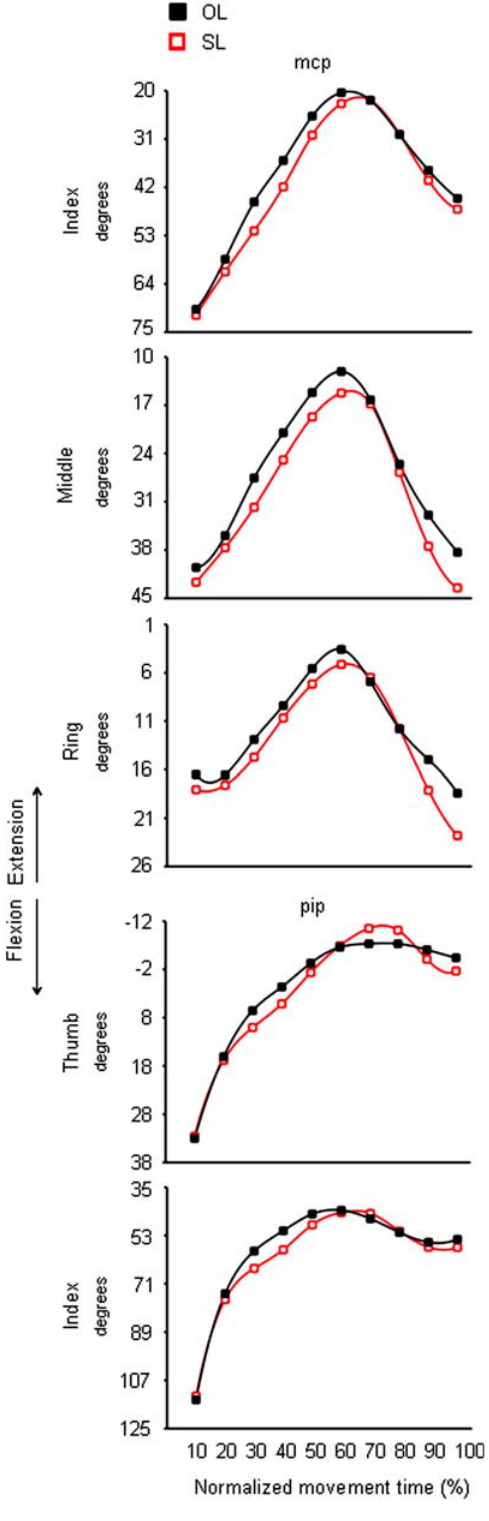
Figure 6. Time course of finger motion during reaching for the large target either in the absence or in the presence of an odour evoking a small object. Each trace denotes the average angular excursion of a representative subject (subject 15) for the mcp joint of index, middle and ring fingers (upper panels), and the pip joint of the thumb and index finger (lower panels) when performing the ‘OL’ (black squares) and the ‘SL’ (red squares) conditions. Positive values